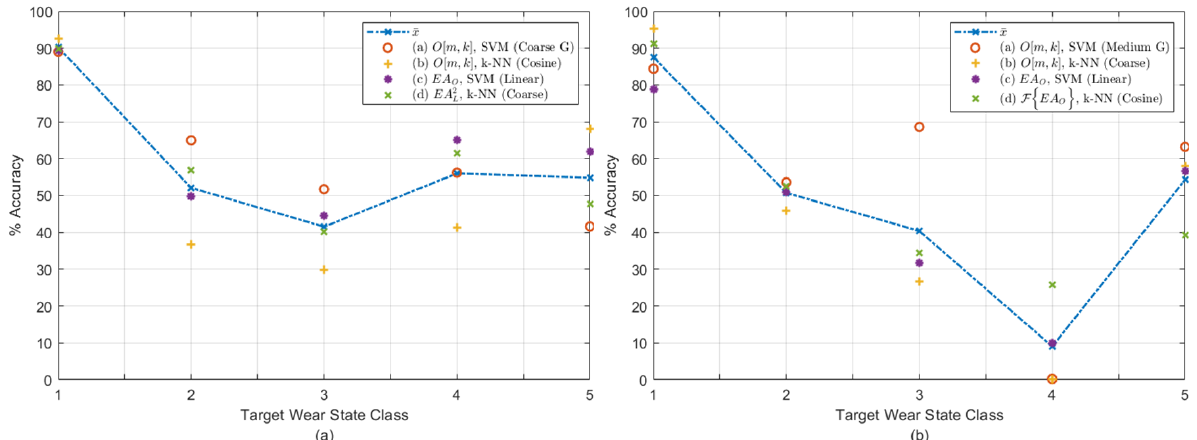
Figure 9. Classification accuracy for the individual classes (1 to 5) for ( a ) linear wear-state classes and ( b ) non-linear wear-state classes, which corresponds to the diagonal of the confusion matrices in Figures 7 and 8,